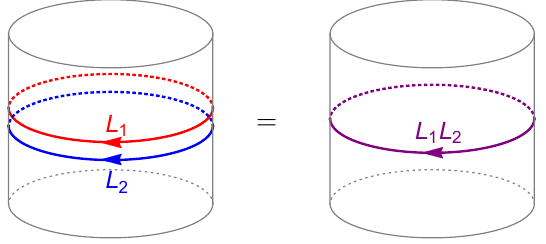
Figure 1 . Fusion of a pair of TDLs L 1 and L 2 wrapping the spatial loop on the cylinder.